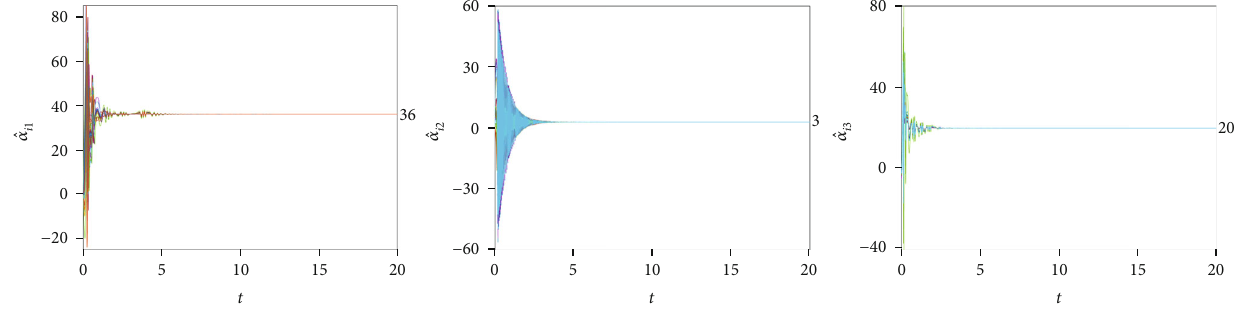
Figure 10: Identi fi cation of the uncertain parameters b α